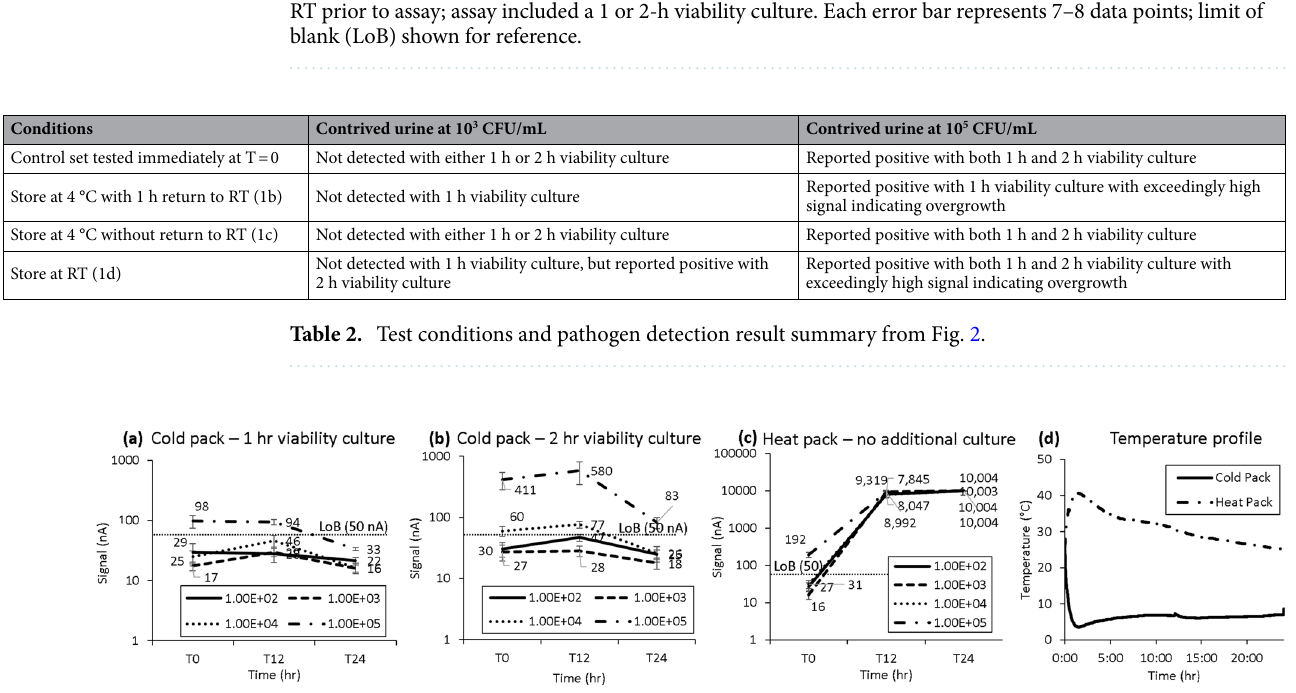
Figure 3. Urine calibration curve tested at 0, 12, and 24 h. Urine stored with one cold pack and tested with either ( a ) one or ( b ) 2 h of viability culture. ( c ) Urine stored with one heat pack and cultured for 1